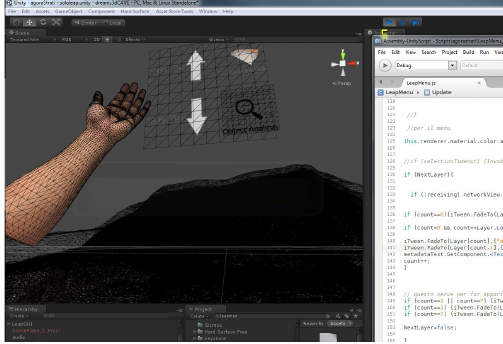
Figure 9. Snapshot of the Implementation phase - Study of user behaviour (fig 10): testing phase on different users with different skills to analyze the actual effectiveness of the gestures. Through a real-time feedback the gestures were corrected and revised according to the behaviour of the users.